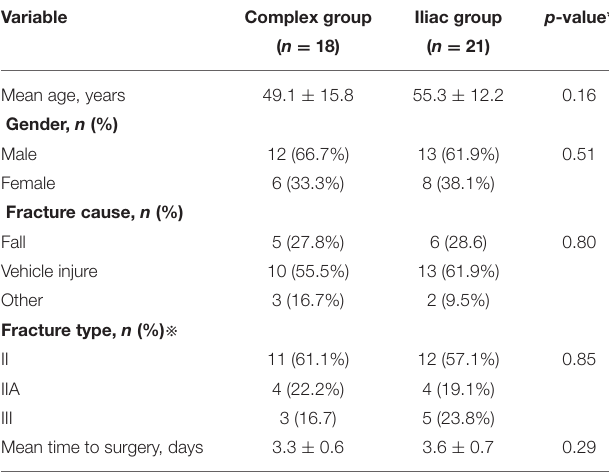
TABLE 1 | The clinical and demographic characteristics of the two